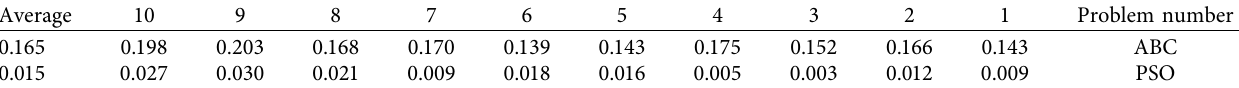
Table 9: Mean relative deviation percentage (RPD) of algorithms for each combination of sample problems in problem solving. Average